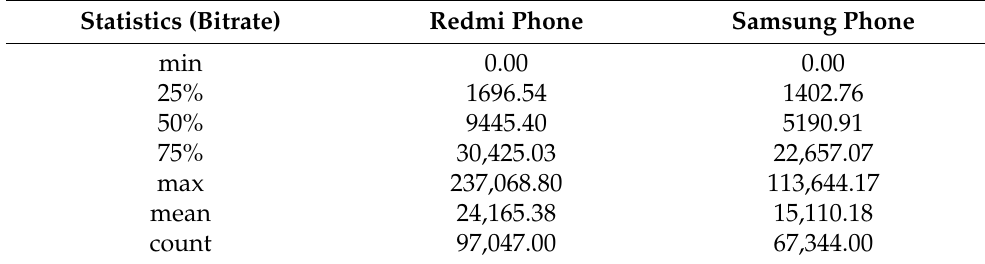
Table 5. Statistics of collected bitrate with used